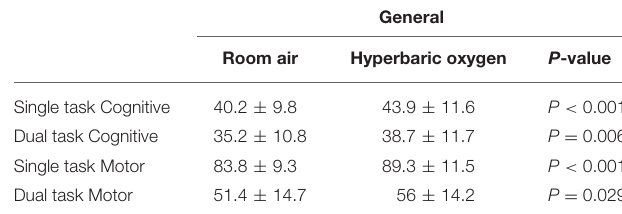
TABLE 2 | Cognitive and motor task